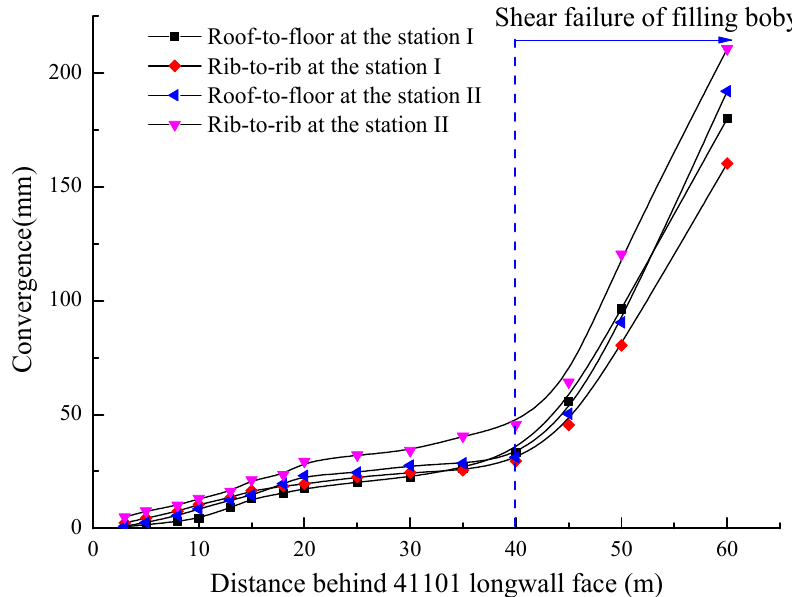
Figure 3. Deformation of surrounding rocks of gob-side entry retention work (cemented materials were used to fill space in frameworks).